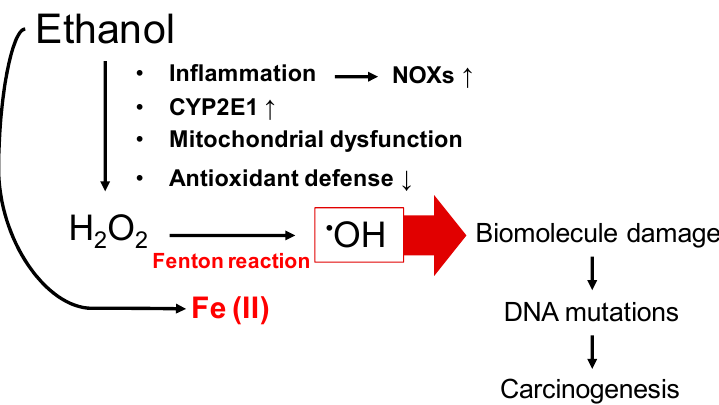
Figure 2. Schematic overview of current knowledge of mechanisms leading to ethanol and iron-induced carcinogenesis. CYP2E1: Cytochrome P450 2E1; NOXs: NADPH oxidases.